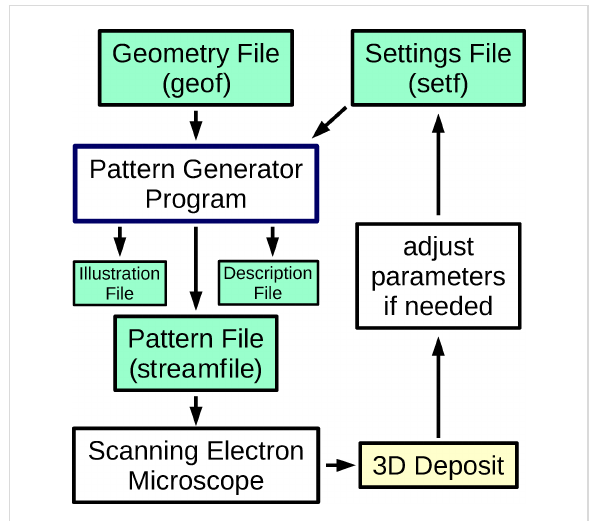
Figure 1: Block-flow diagram of the environment of the pattern gener- ator program using input from a geometry description (geof) of the target 3D structure and process-specific parameters (setf). Besides the pattern file, a file for illustration purposes is generated which can be loaded by the program Gnuplot [29] in order to visualize the generated pattern. In addition, a description file, containing all used parameters for the pattern generation, is